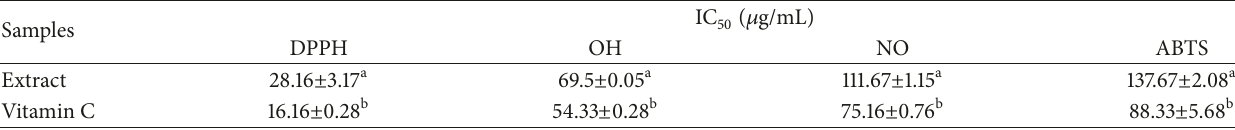
Table 2: Fifty percent inhibitory concentration value of the free radical scavenging potential of the water-ethanol extract of Tetrapleura tetraptera.